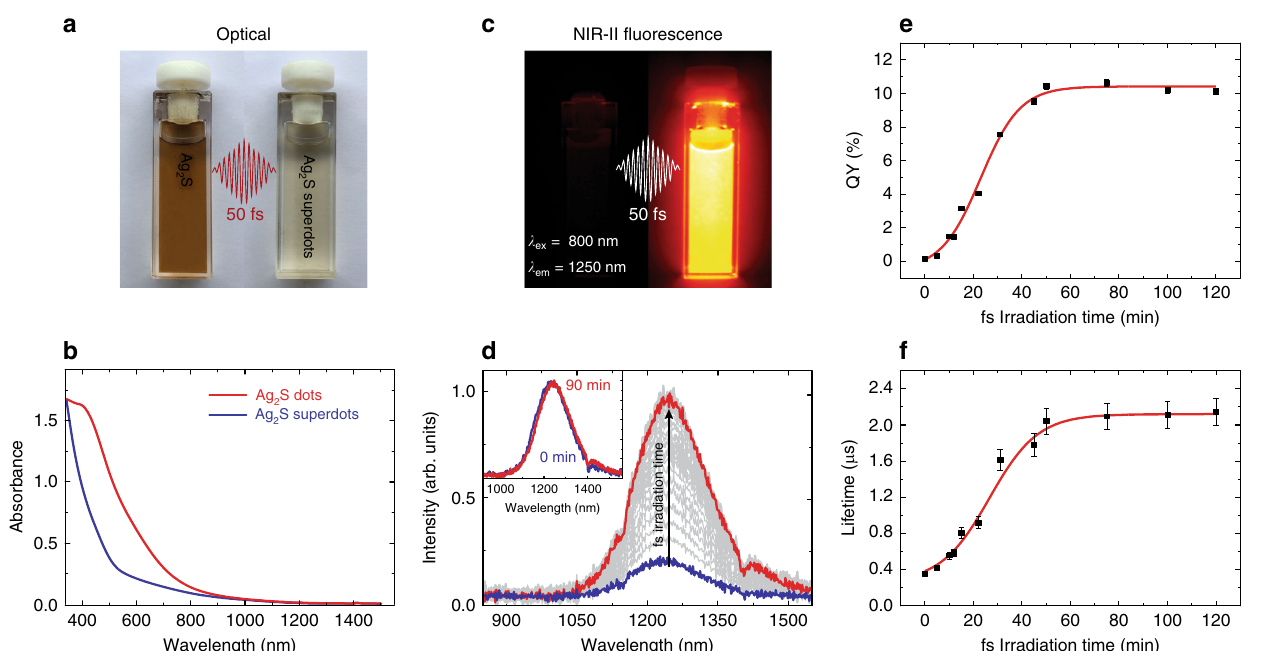
Fig. 2 Optical transformation of Ag 2 S dots into superdots. a Optical images, b UV-VIS-NIR extinction spectra, and c NIR-II fl uorescence images of a colloidal dispersion of Ag 2 S dots in CHCl 3 before and after ultrafast laser irradiation (50 fs, 90 min, 9 W cm − 2 ). For the acquisition of NIR-II fl uorescence images, the dispersions were optically excited with an 808 nm continuous wave laser diode (100 mW cm − 2 ). d NIR-II emission spectra generated by a colloidal suspension of dots in CHCl 3 during a 90-min-long ultrafast laser irradiation. The inset shows the normalized emission spectra of the sample before and after the laser irradiation. e Fluorescence quantum yield and f fl uorescence lifetime of Ag 2 S dots in CHCl 3 after being subjected to ultrafast laser irradiations processes of different durations. The error bars in e were calculated taking into account the equipment uncertainty that was determined from the statistical analysis of fi ve measurements. In f , each measurement was repeated fi ve times and the error bars are the standard error of the mean of each series of measurements. Repetitive measurements to calculate both mean and error were performed on the same sample. The small relative uncertainties in QY (2%) make the error bars too small to be visualized in e . In f , the error bars correspond to the standard error of the mean after measuring and analysing 10 decay curves for each sample. In e and f , the squares correspond to the experimental data and the red lines are guides for the